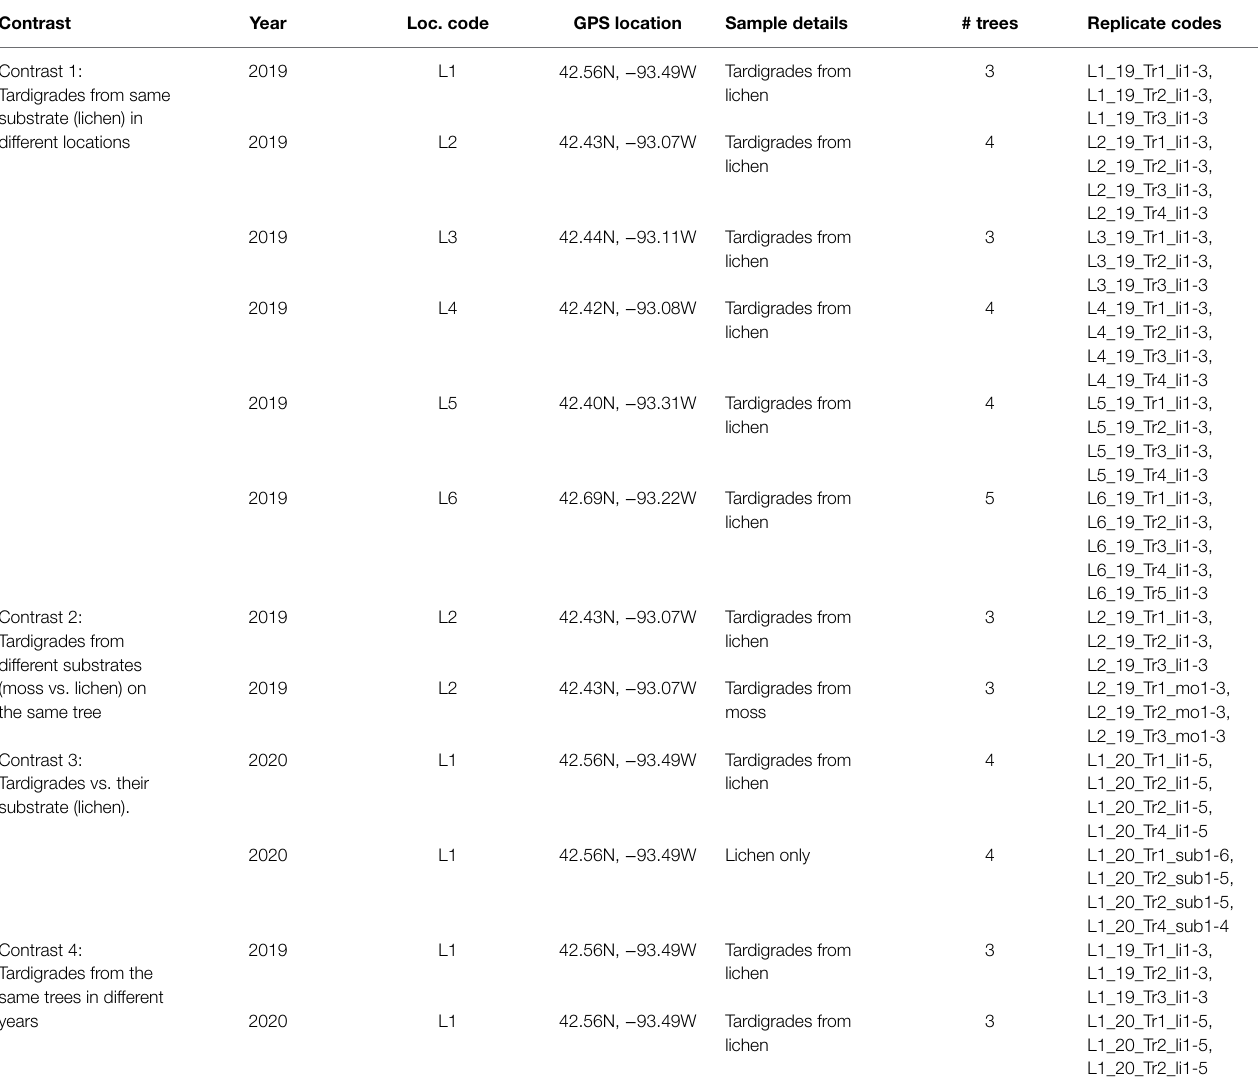
TABLE 1 | Details of samples used in the experiment. Contrast Loc. code Sample details # trees Replicate